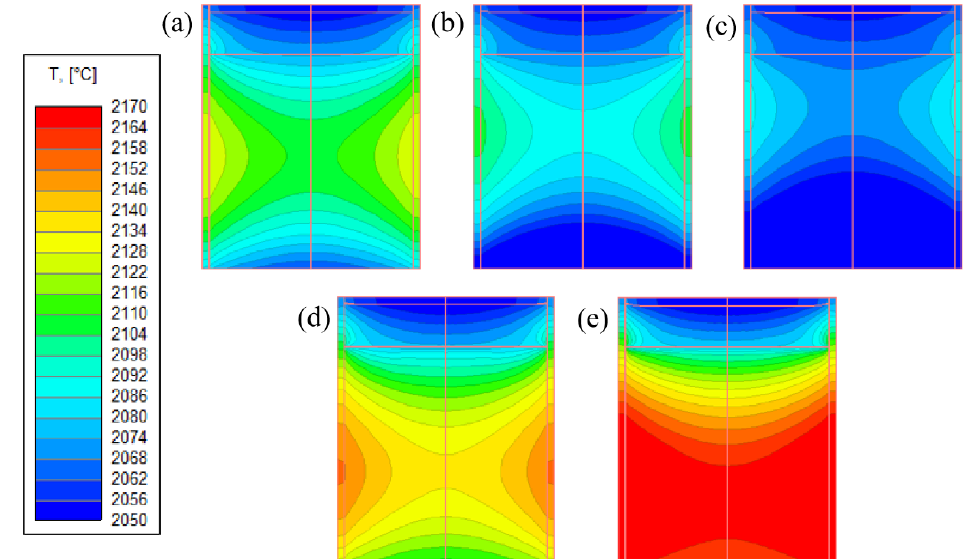
Figure 3. Effect of heating body position on temperature field distribution; ( a ) 0 mm, ( b ) 15 mm, ( c ) 30 mm, ( d ) − 15 mm, and ( e ) − 30 mm.